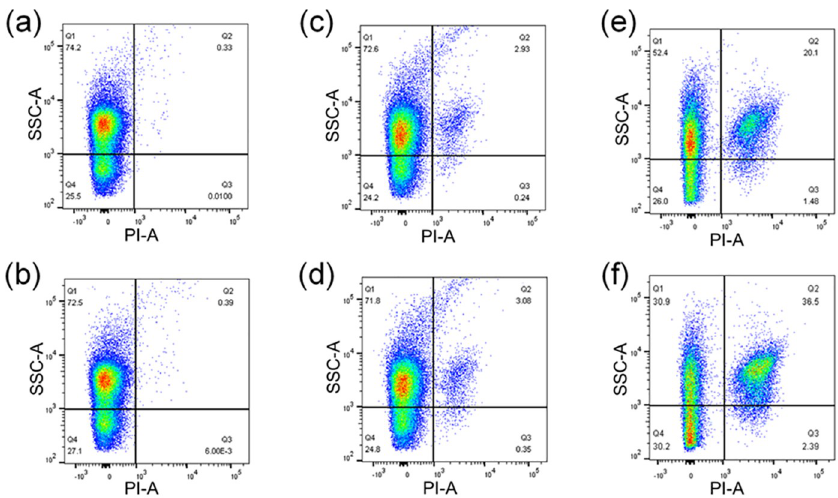
Fig 5. Flow cytometry analysis for bacterial cell permeability of each sludge samples. (a) Control group, (b) Nano group, (c) Tet group, (d) Ery group, (e) Nano&Tet group, (f) Nano&Ery group.